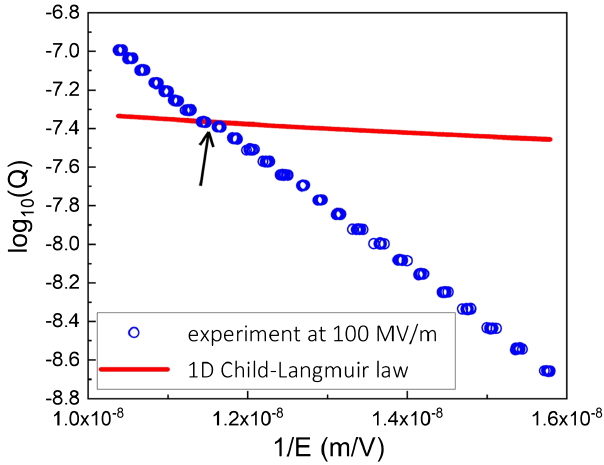
FIG. 9. Millikan plot for 100 MV = m (blue circles) showing the parallel shift denoted with an arrow and is indicative of a space charge dominated regime that differs from the Child Langmuir law (red line). Here, E stands for rf